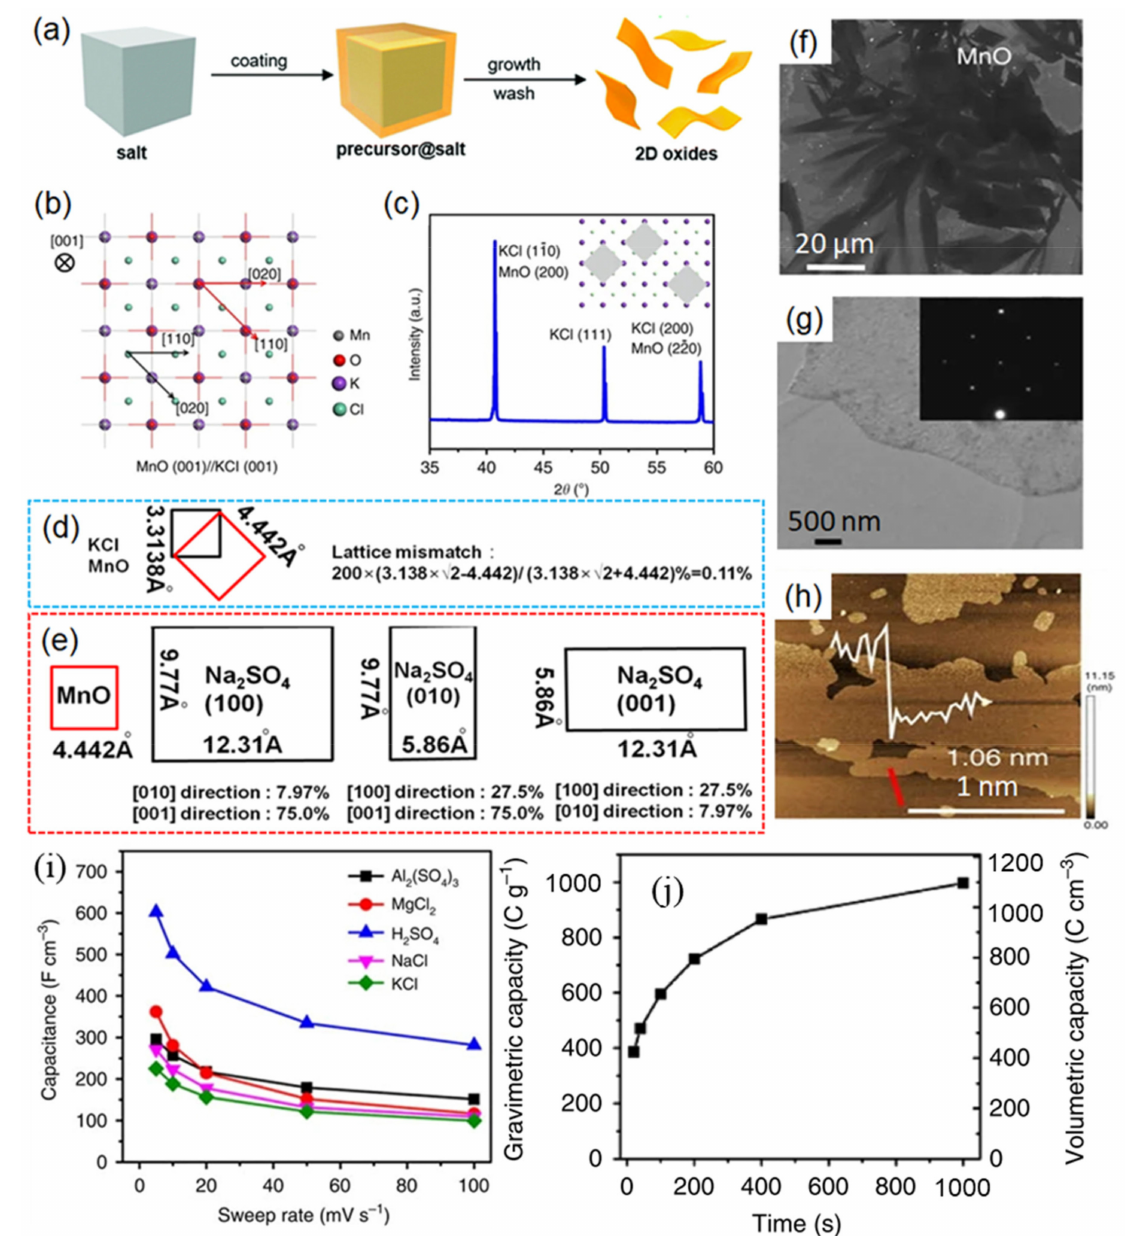
Figure 3. ( a ) Schematic illustration of salt-templating synthesis. ( b ) Proposed mechanism of the salt-templating growth of 2D MnO. ( c ) XRD pattern of 2D MnO on KCl. The inset is a schematic representation of MnO on KCl. ( d ) Lattice mismatch of MnO and KCl. ( e ) Lattice mismatch of MnO and Na 2 SO 4 . ( f ) SEM, ( g ) TEM, and ( h ) AFM images of 2D MnO. The inset of ( g ) shows the corresponding selected area electron diffraction (SAED) pattern. The inset of ( h ) shows the corresponding thickness of the 2D oxide. Scan line is shown in red. ( i ) Electrochemical performance of 2D h -MoO 3 in aqueous electrolytes: volumetric capacitance as a function of the sweep rate in different aqueous electrolytes. ( j ) Electrochemical performance of 2D h -MoO 3 in a Li-ion-containing organic electrolyte: gravimetric and volumetric capacity as a function of charging/discharging time. Reprinted (adapted) from Reference [36] with permission from Springer